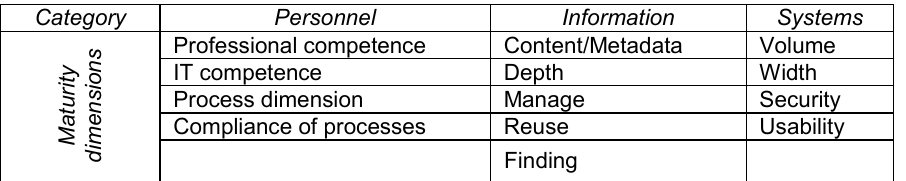
Table 1 – Review of the categories and dimensions of the maturity model Таблица 1 – Обзор категорий и размеров модели зрелости Tabela 1 – Pregled kategorija i dimenzija modela